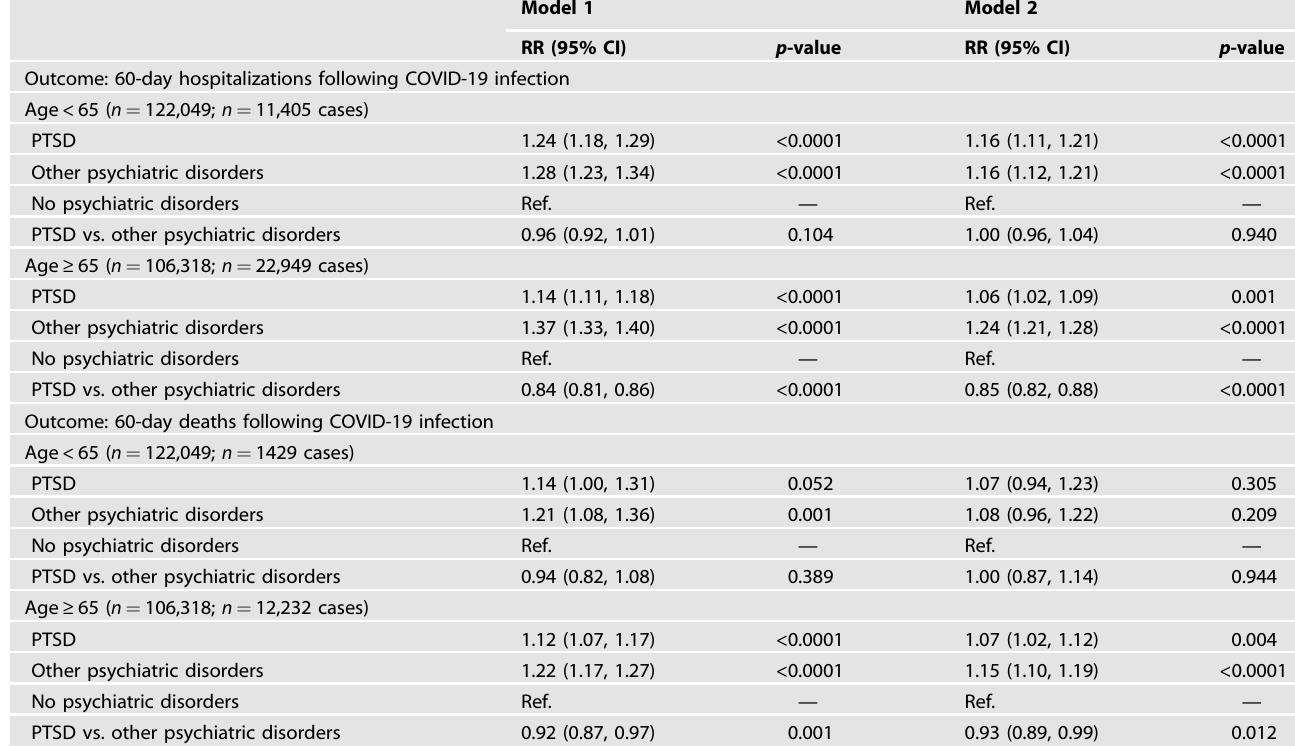
Table 3. Age-strati fi ed generalized linear models for associations of PTSD and other psychiatric disorders with 60-day hospitalization and death following COVID-19